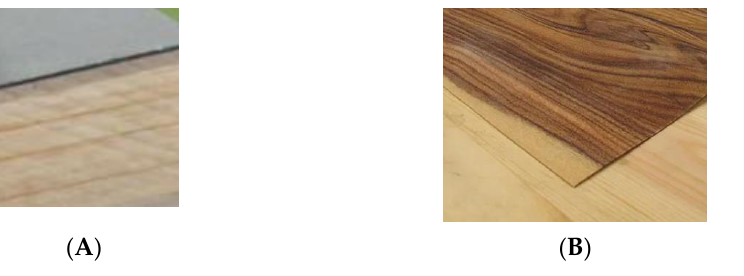
Figure 14. Paper impregnated with melamine on the surface of pine ( A ) and a walnut veneer on the surface of pine ( B ).